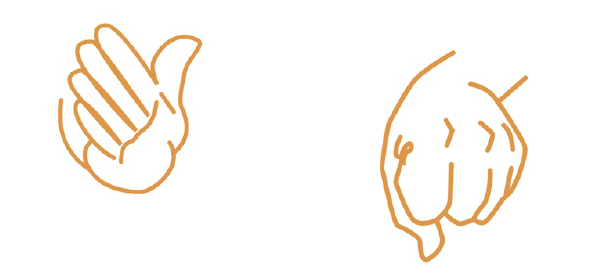
Figure 4. Hands posture for a “bee”